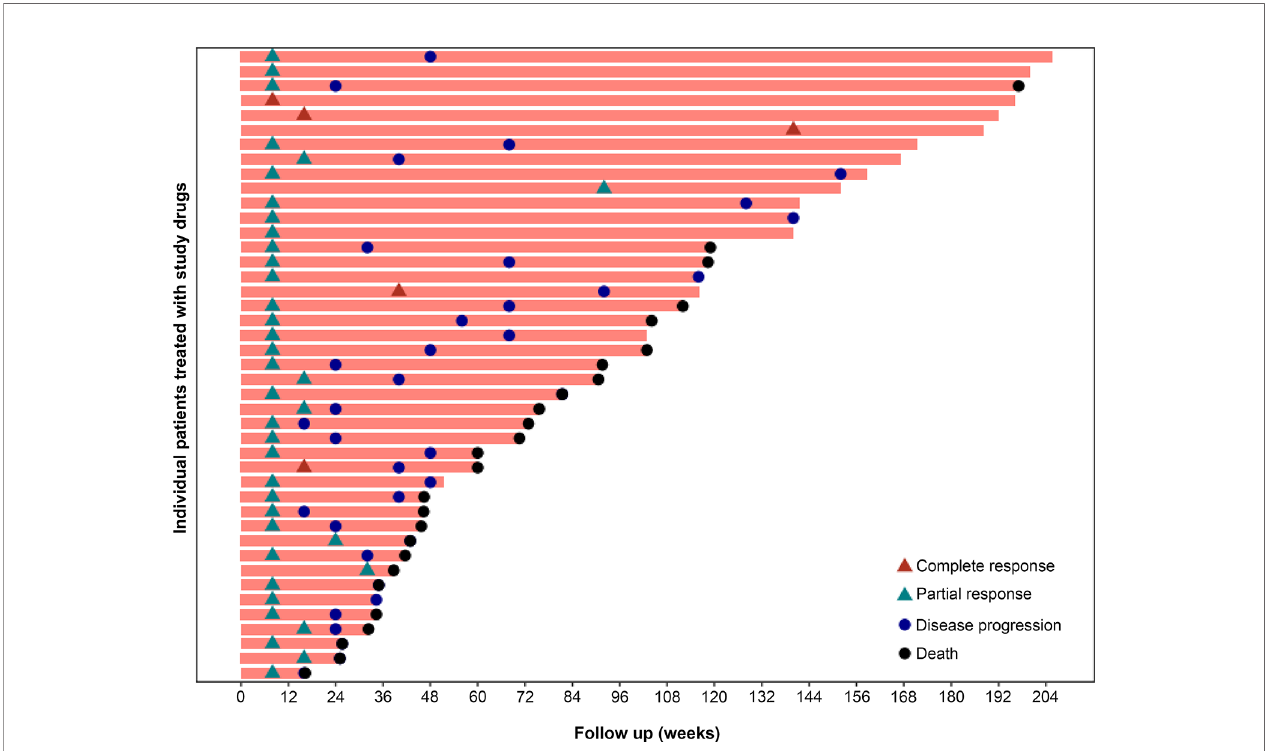
FIGURE 3 | Time to response and duration of study treatment. A total of 43 of the 60 patients had a response, including 5 patients with CR and 38 patients with PR. In the 43 patients with best response of CR or PR, the median TTR was 1.9